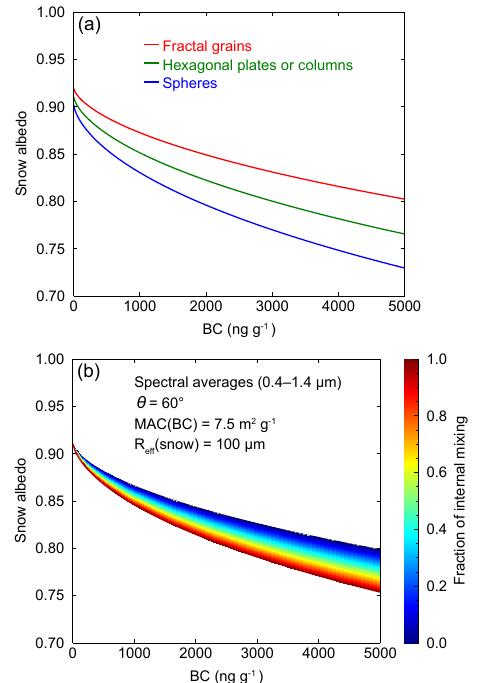
Figure 10. Spectral albedo of snow as a function of BC mixing ra- tios in snow by using SMDAS model for (a) the irregular morphol- ogy of snow grains (fractal grains, hexagonal plates or columns, and spheres), (b) internal–external mixing of BC and hexagonal plate or column snow grains. Also shown are model parameters, includ- ing integrate spectral wavelengths (400–1400nm), solar zenith an- gle ( θ) , mass absorption coefficient (MAC) of BC, and snow grain optical effective radius ( R eff )